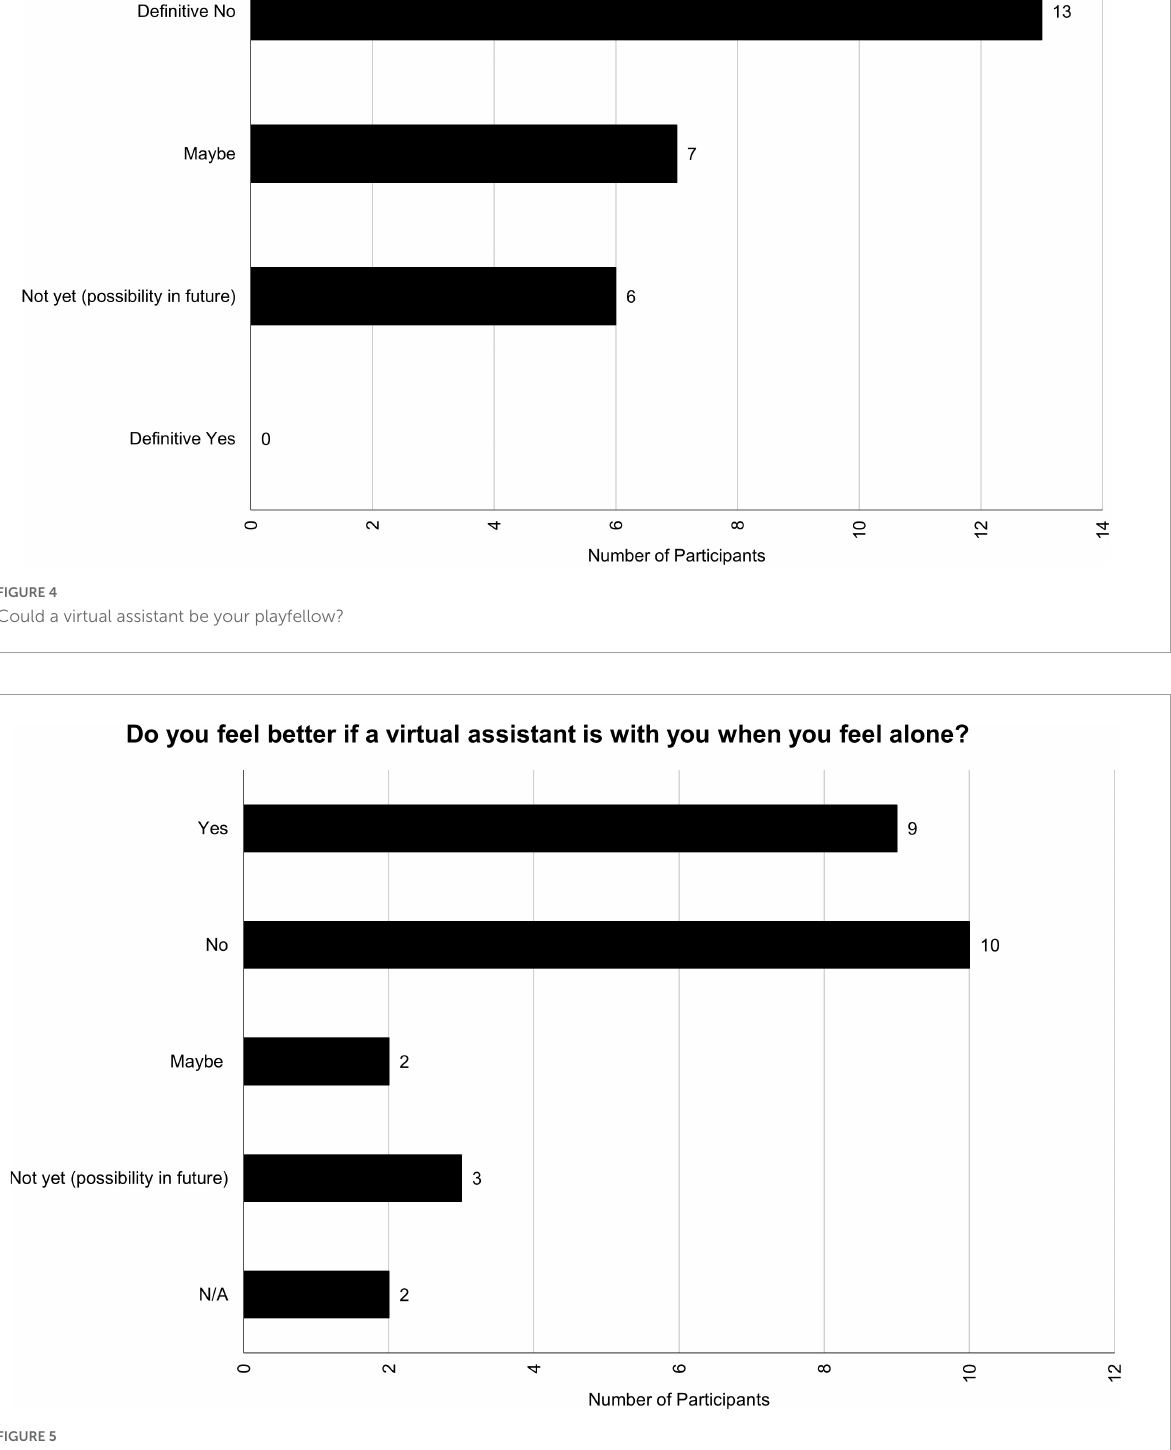
FIGURE5 Do you feel better if a virtual assistant is with you when you feel